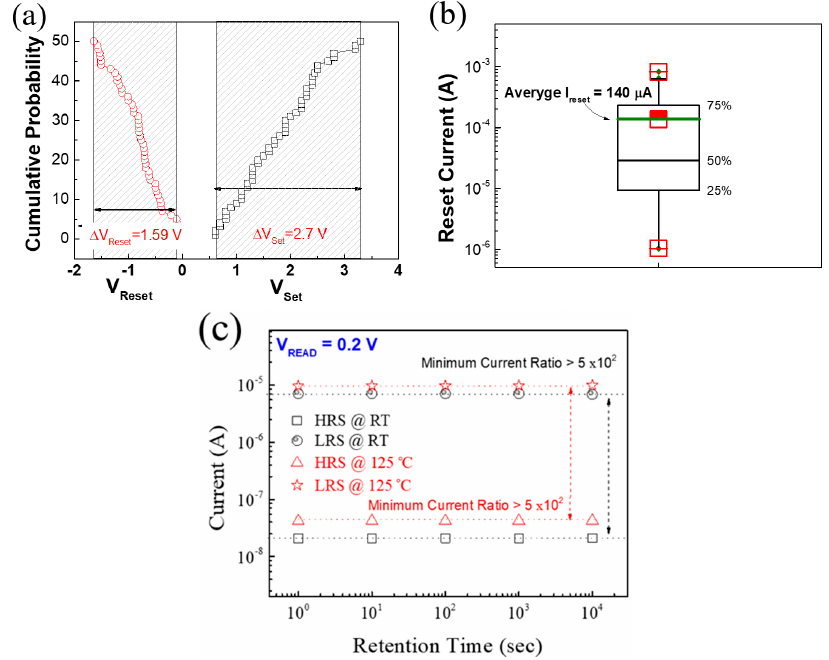
Figure 3. Analysis of ( a ) the set/reset voltage variations and ( b ) the current variations for the PtSi/O-doped ZrN/TiN RRAM cells. ( c ) Retention properties for the devices with active size of 150 × 150 µ m 2 at 0.2 V in the LRS and HRS for 10 4 s at 25 ◦